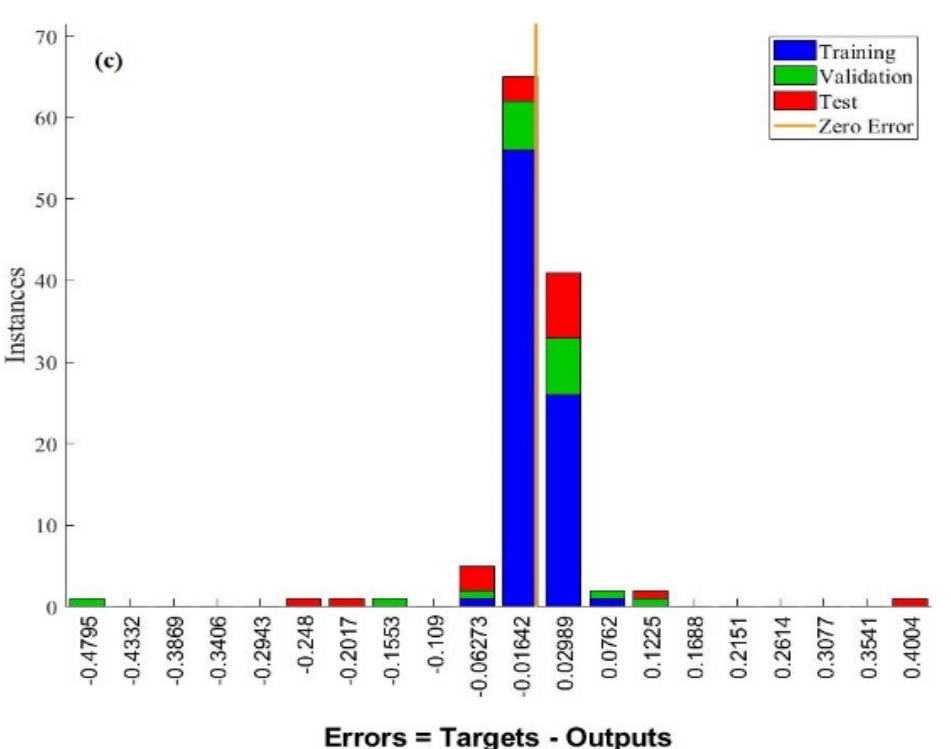
Figure 3. ( a ) Error histograms for of ANN model-I. ( b ) Error histograms for of ANN model-II. ( c ) Error histograms for of ANN model-III. Table 22. Performance results for ANN models.